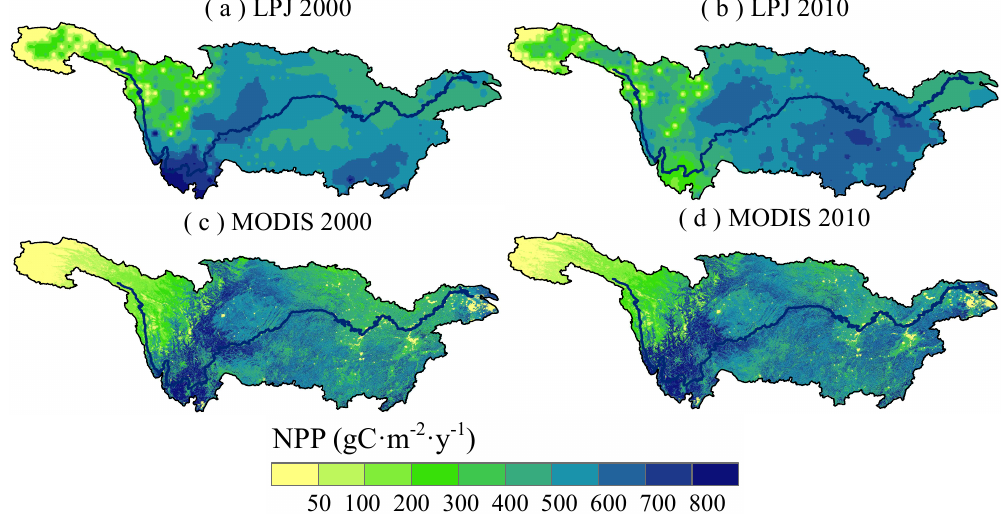
Figure 2. Spatial distribution of annual mean NPP in Yangtze River basin in 2000 and 2010.